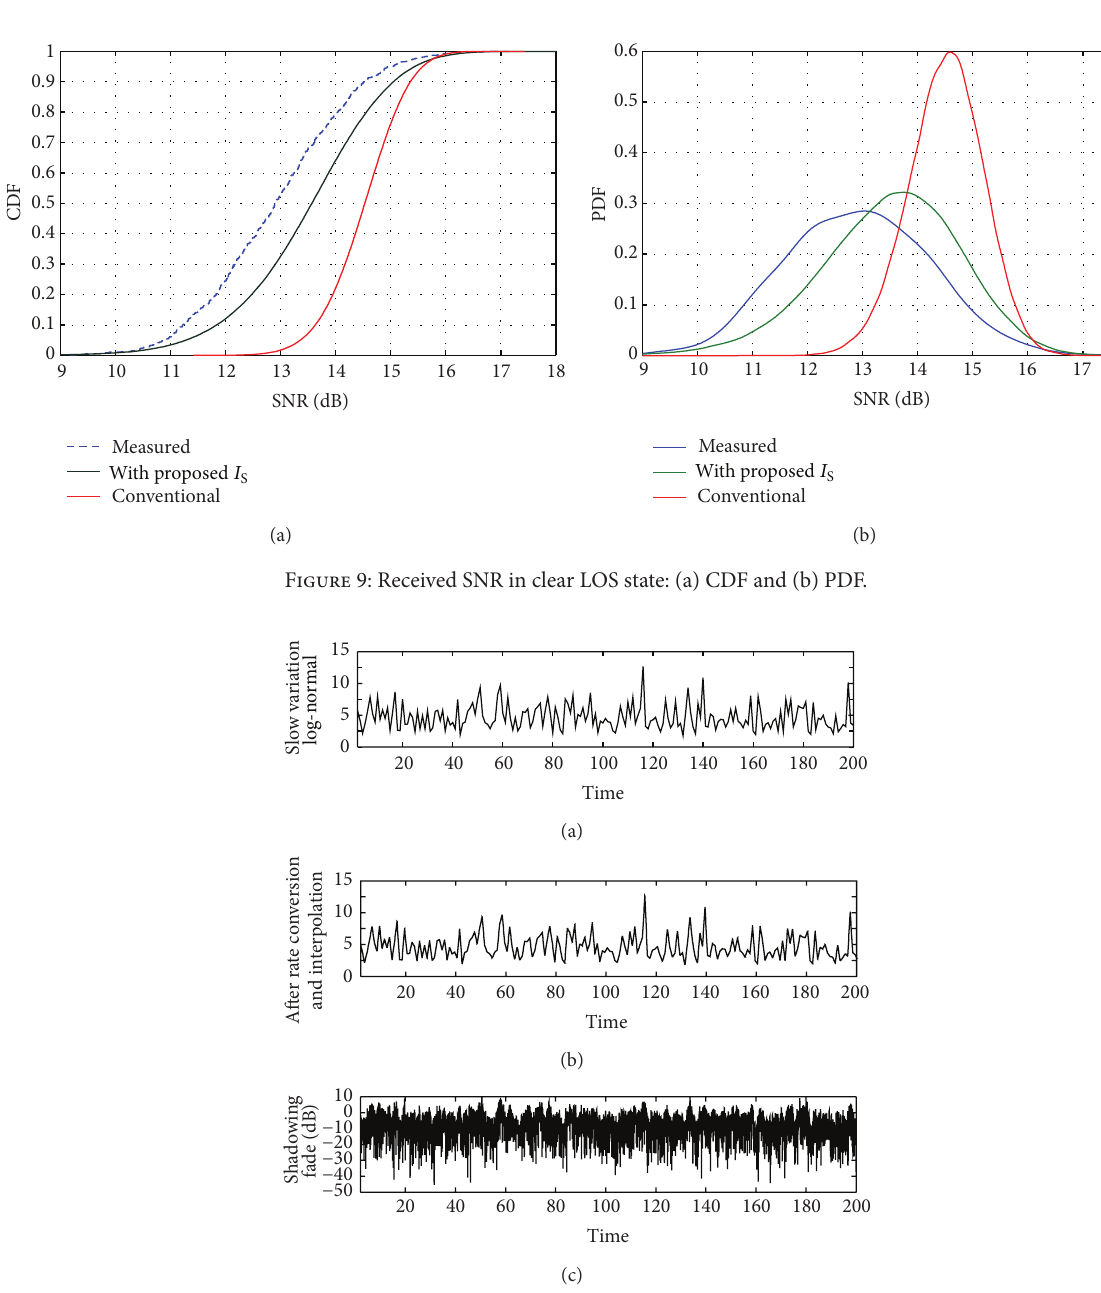
Figure 10: Simulated fade attributed to shadowing: (a) the generated slow variation lognormal distribution, (b) signal after rate conversion and interpolation, and (c) the aggregated